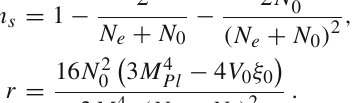
parameters corresponding to the R 2 inflation [1,5,7] putting √ C α = 1 and, so, N 0 = 3 / 2 ≈ 0 .